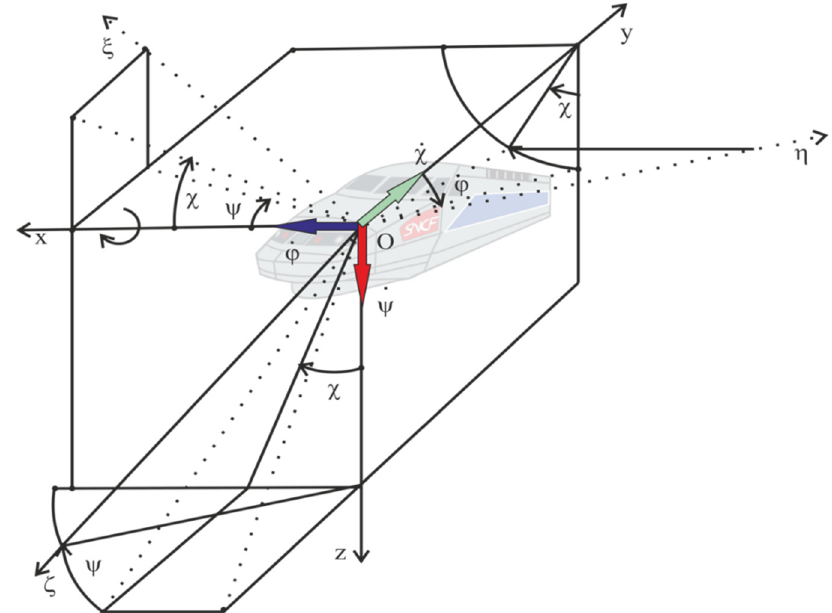
Figure 2. Three independent rotation angles 𝜙, 𝜒, 𝜓 in relation to 𝑂 (cid:2869) 𝑥, 𝑂 (cid:2869) 𝑦, 𝑂 (cid:2869) 𝑧 axes.